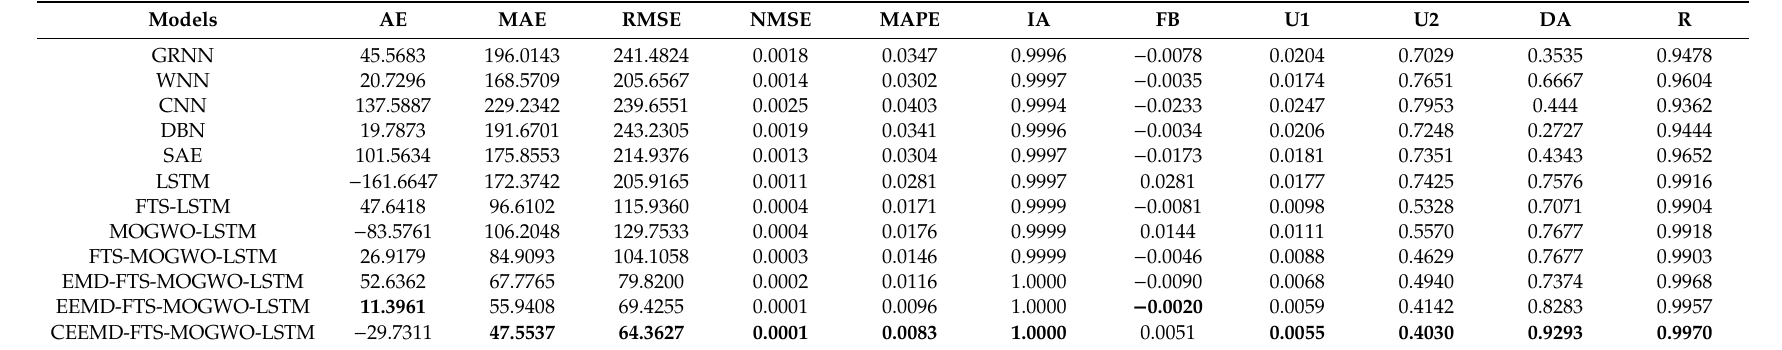
The values in bold indicate the best values of each benchmark